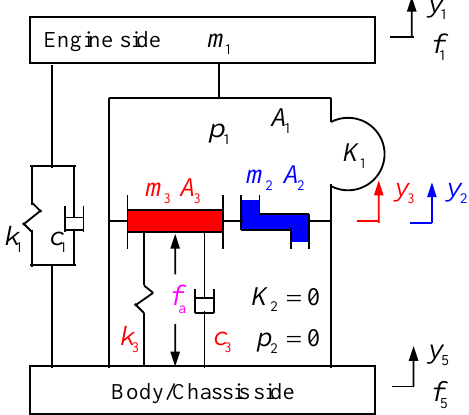
Figure 2. Lumped parameter mechanical model for the AHM-IT-DM-OCA [22].